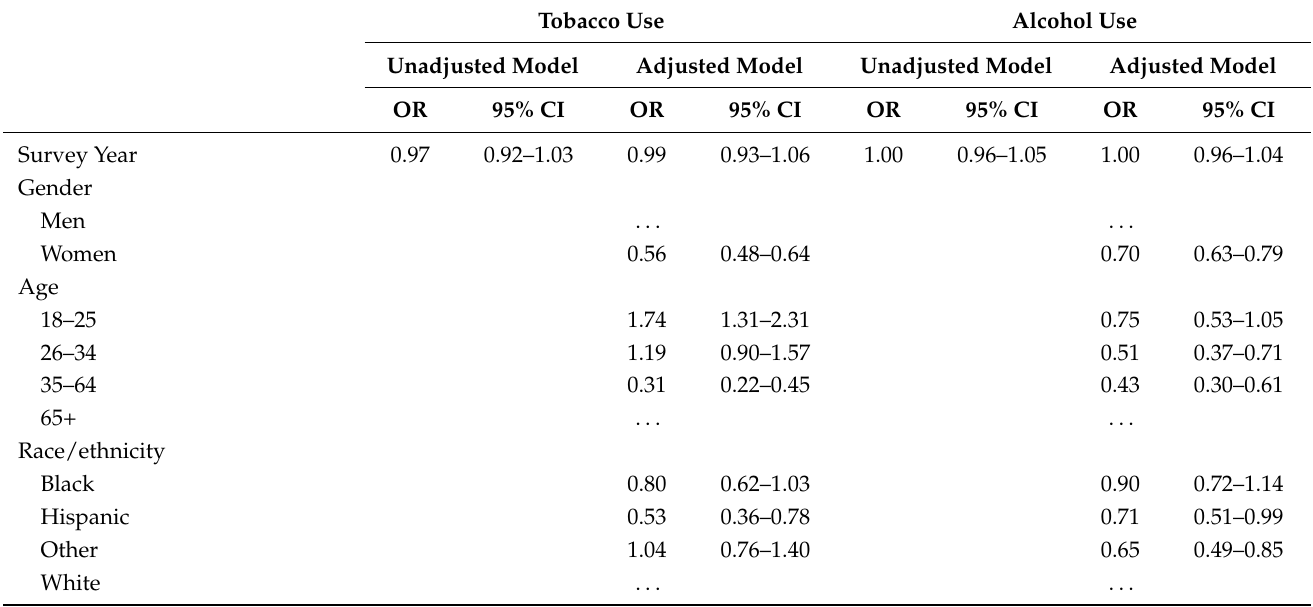
Table A2. Test of trends in tobacco and alcohol use among adults with heart disease: pooled sample of NSDUH